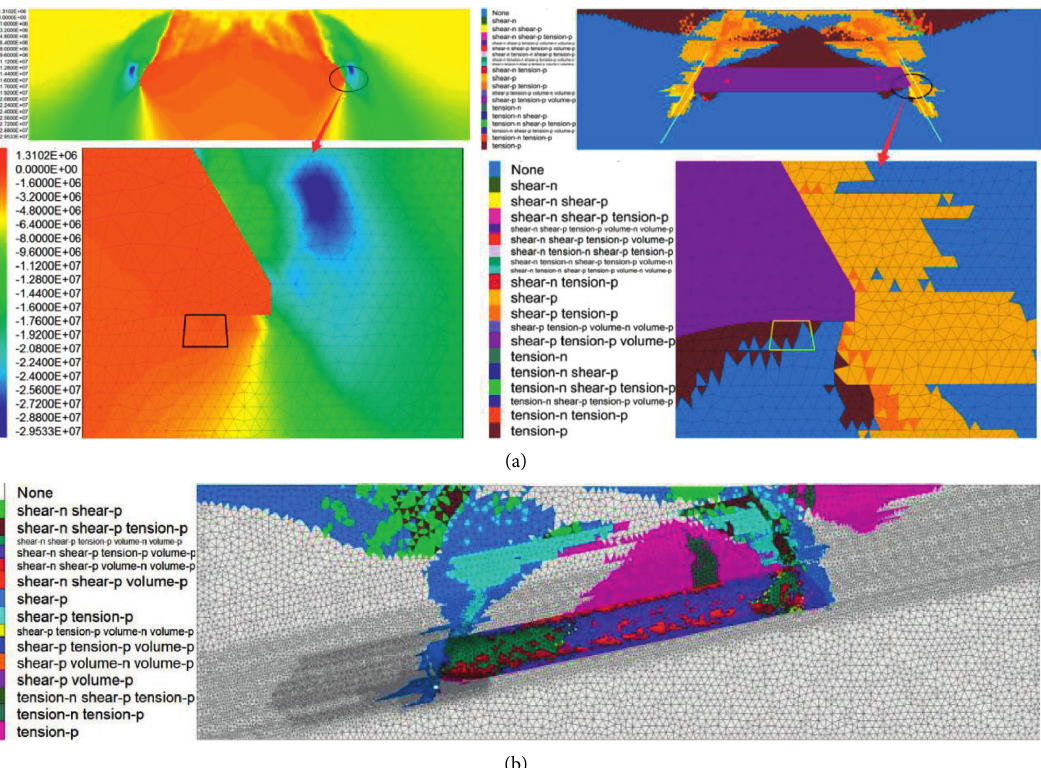
Figure 18: Modelling results of SLL [34, 35]. (a) Modelling results of SLL in flat coal seam. (b) Modelling results of SLL in inclined coal